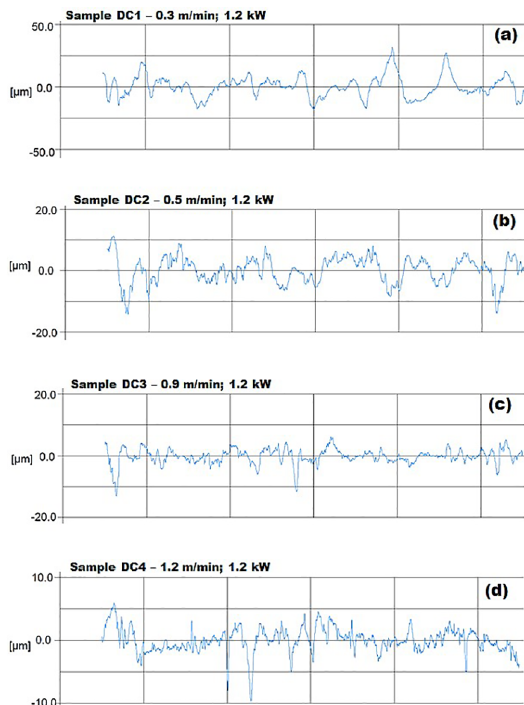
Figure 4. Surface roughness measurements for the laser deposited Cu samples; (a) DC1 deposited with a scanning speed of 0.3 m/min, (b) DC2 deposited with a scanning speed of 0.5 m/min, (c) DC3 deposited with a scanning speed of 0.9 m/min, (d) DC4 deposited with a scanning speed of 1.2